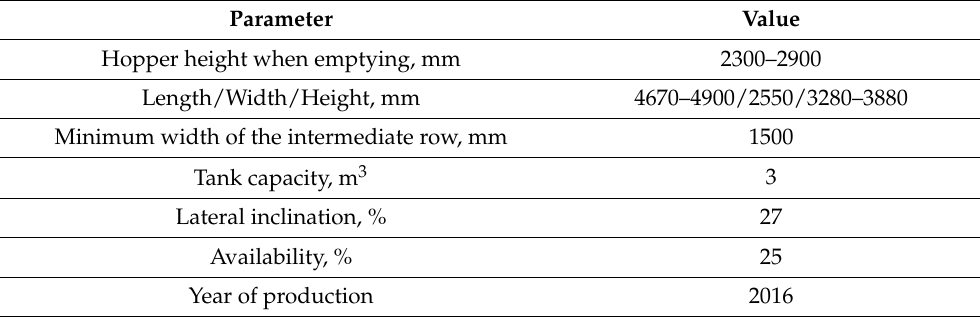
Table 2. Technical parameters of trailed grape harvester Pellenc 8090 SP [19].